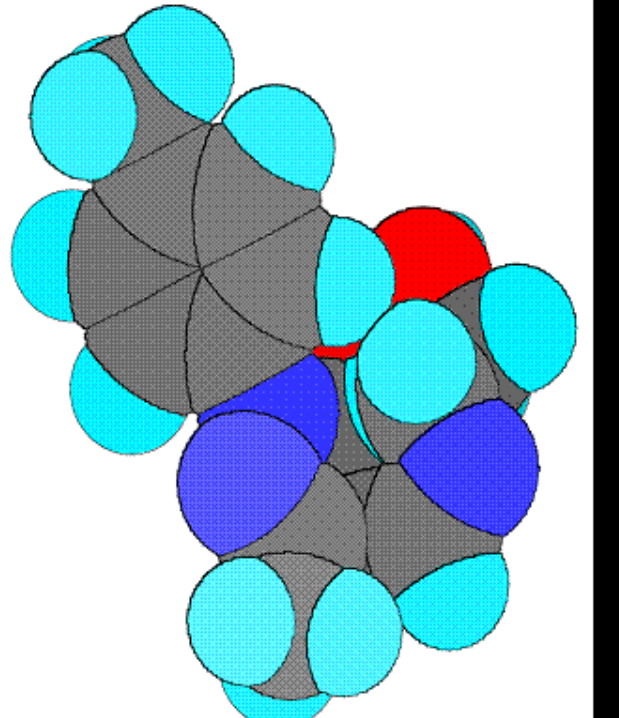
Figure 3. Space filling diagram of schiff base ligand(III) 5-Hydroxy-3-methyl-1-p-tolyl-1H-pyrazole-4-carbaldehyde (II) Yellow crystal obtained, yield 76% Melting point: 184 ° C FT-IR (KBr) u max (cm -1 ): 3400-3300m (OH hydrogen bonded ), 2809-2728vs (C–H aldehydic , doublet), 1674s (C=O), 1598vw (C=N cyclic ). 1 H-NMR (300 MHz, CDCl 3 ): δ = 9.65 (s, 1H, CHO), 8.45 (s (enolic), 1H, OH), 7.2-7.7 (m, 4H, Ph), 2.2